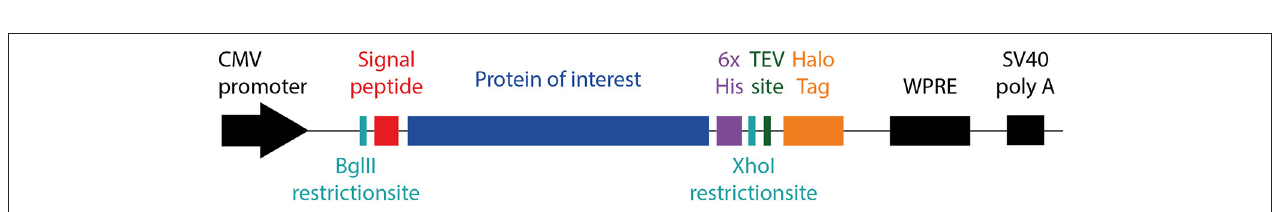
FIGURE 3 | Schematic illustration of a part of the universal vector used for the production of HaloTag proteins. In the general pcDNA3-WPRE vector starting with a CMV promoter and including the HaloTag sequence and the WPRE sequence, which enhances expression, we ligated an insert consisting of a BglII restriction site, then a signal peptide, the DNA sequence of the protein of interest, followed by 6-Histidines and ending with an XhoI restriction